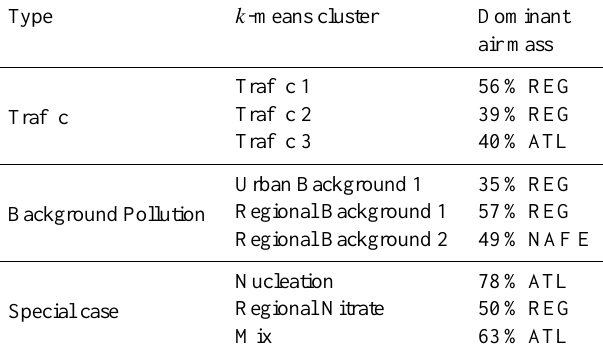
Table 3. Air mass origin dominating at each cluster (average per- centage values). The air mass types are Atlantic (ATL), Regional (REG), North African west (NAF_W), North African east (NAF_E) and European (EUR). Fig. 1. Aerosol size resolved distributions of the nine clusters result of the k -means analysis performed on the SMPS data at all SAPUSS monitoring sites.